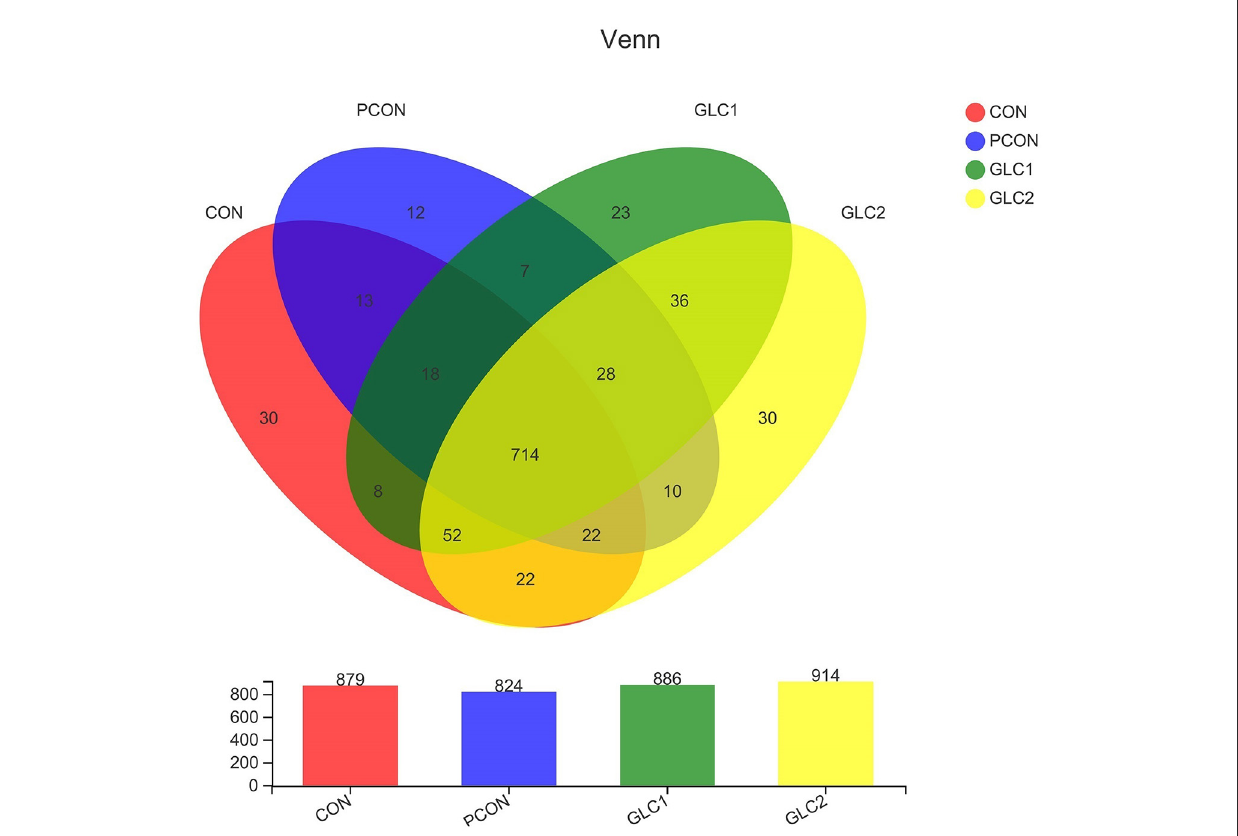
FIGURE2 Effect of Ganoderma lingzhi culture (GLC) supplementation on Venn diagram analysis of the caecal microbiota ( n = 6; CON, control diet; PCON, positive control diet; GLC 1: 1.5% GCL diet; GLC 2: 3% GCL